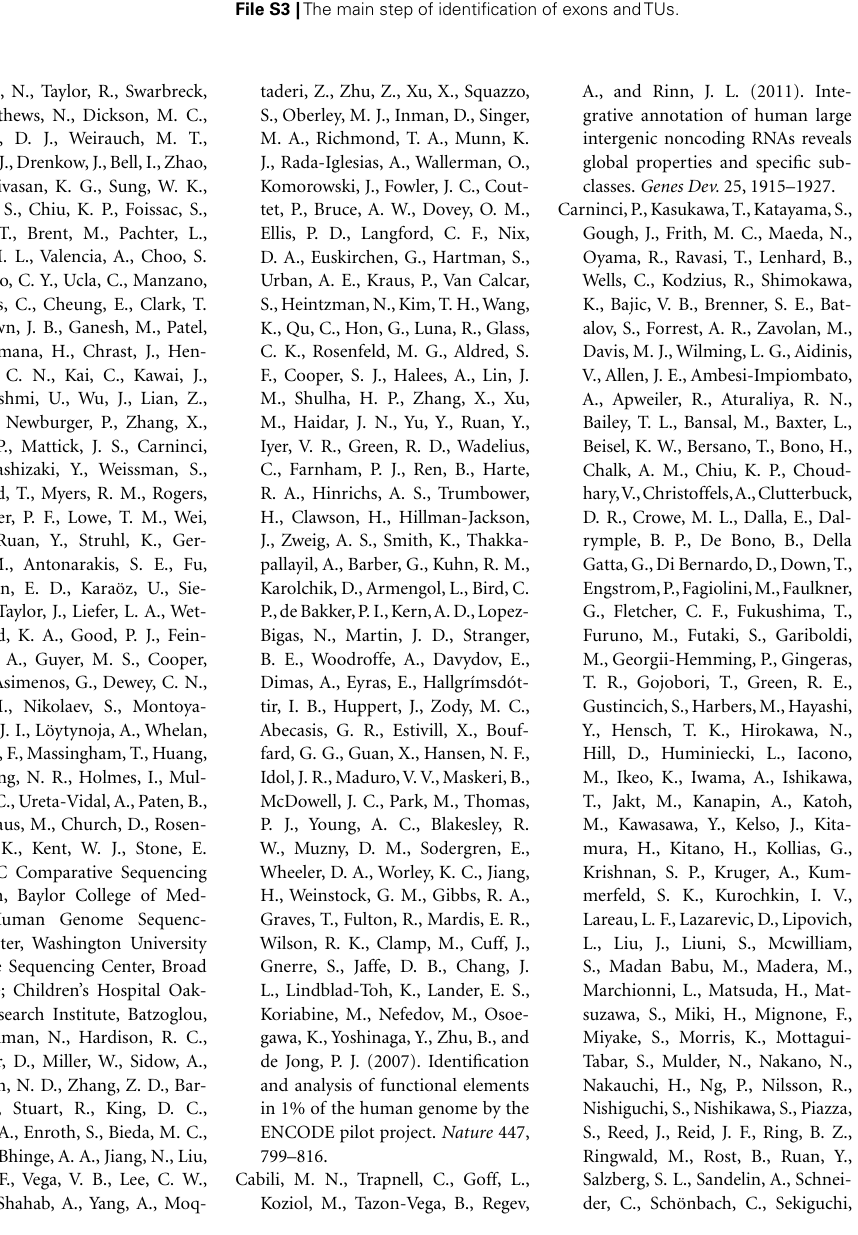
Table S3 | Functional classification of ES cell-associated genes that have antisense RNA. Table S4 | KEGG pathways of the cerebrum-associated genes that have antisense RNA. Table S5 | KEGG pathways of testis-associated genes that have antisense RNA. File S1 | Putatively identified exons in the mouse cerebrum, testis, and ES cells. These files have five columns.They are chromosome, strand, type (“modified” or “no-modified” for distinguishing whether it was revised using split reads), start position and end position. File S2 | Putatively identifiedTUs in the mouse cerebrum, testis, and ES cells. File S3 | The main step of identification of exons